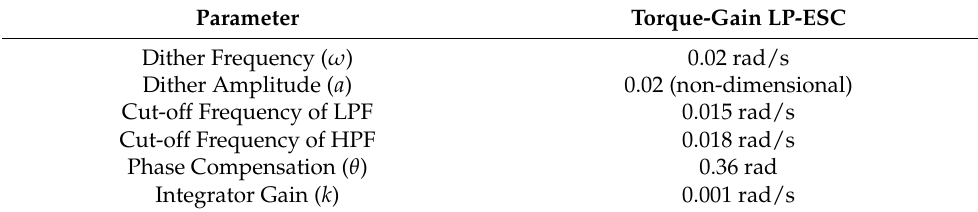
Figure 5. Bode Plot of input dynamics, LPF, HPF, and the dither frequency. Table 2. LP-ESC Parameters of NREL 5MW Region 2 controller (see Figure